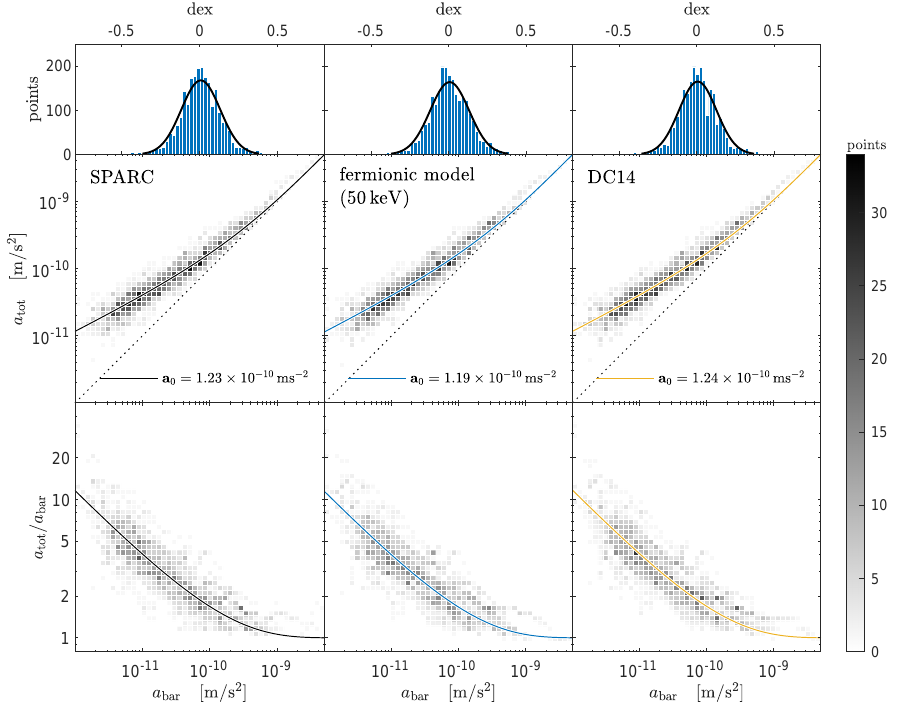
Figure 11. Radial acceleration relation ( top ) and mass discrepancy acceleration relation ( bottom ) for SPARC data and competing DM halo models. Each plot is divided into 50 × 50 equal bins. The baryonic centripetal acceleration a bar is inferred from luminosity observables, while the total acceler- ation a tot is inferred independently from velocity fields. For DM halo models, the total acceleration is composed of the predicted dark and inferred baryonic components, i.e., a tot = a DM + a bar . The corresponding solid curves are the best fits characterized by a specific a 0 . The histogram plots ( a ) . The greyscale legend shows the number ( upper row ) show a Gaussian distribution of log 0 / a 0 10 of points per bin (2396 for the 120 SPARC galaxies used). Reproduced from